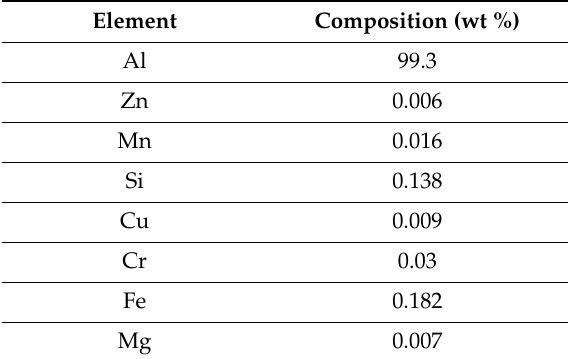
Table 1. Composition of the AA1100 Al alloy.